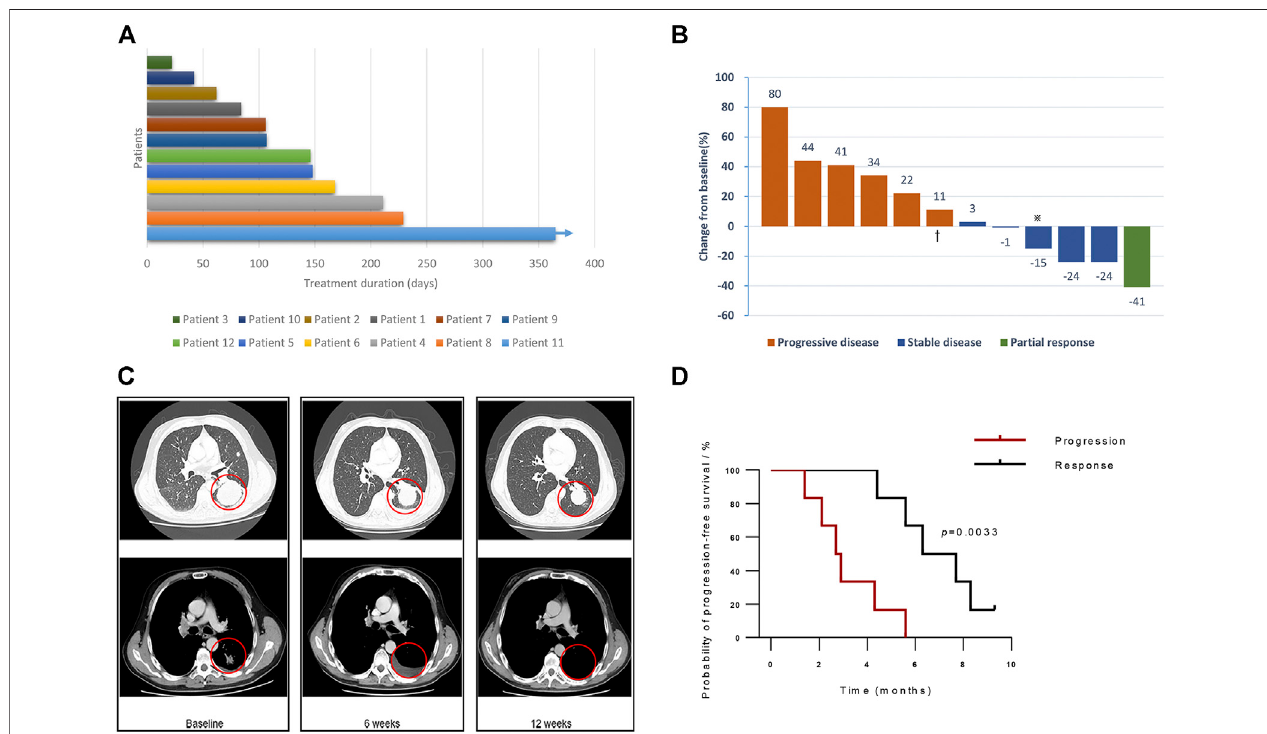
FIGURE1| Clinicalef fi cacyofPD-L1blockade. (A) Investigator-assesseddurationoftreatment.Thearrowindicatescensoredpatientwithfollow-upongoingafter one year. (B) Thecon fi rmedmaximumreductionoftargetlesions,accordingtotheinvestigatorandauthorizedradiologist.Colorsofbarsrepresentingthebestresponse con fi rmed during follow-ups. Red bars represent progressive disease, blue bars represent stable disease, and green bars show partial response. Patient two was con fi rmed of nontarget lesion progression during the one-year follow-up. (C) Representative computed tomography (CT) scans of Patient 11, who achieved a partial responsetoatezolizumab. (D) Comparison ofestimated progression-free survival oftheresponsegroupand the progression group( p < 0.005). Note: ※ :Patient 11, † : Patient